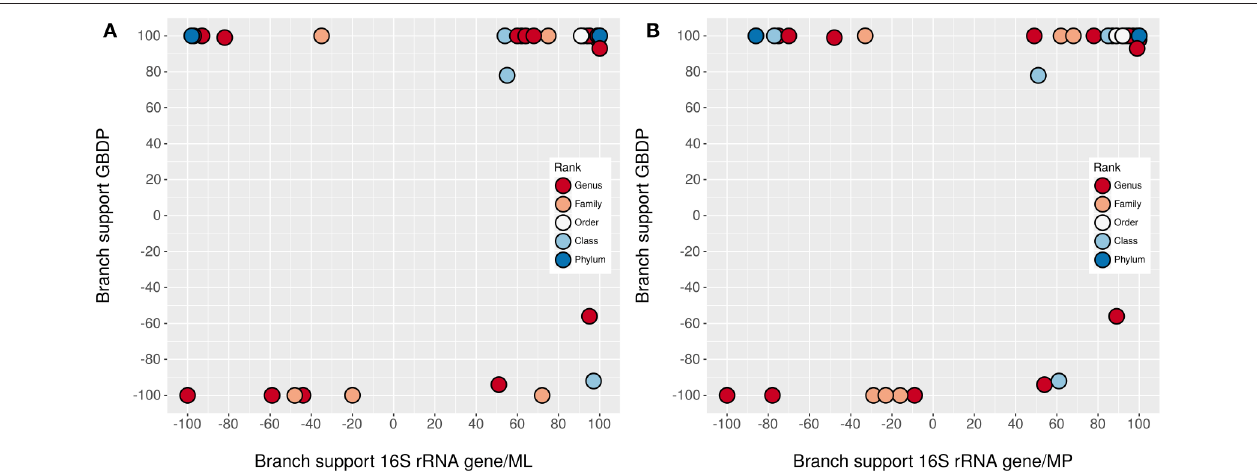
FIGURE 5 | Comparison of branch support. Shown are the negative or positive branch support values for each taxon inferred from whole genomes with GBDP in comparison to those inferred from 16S rRNA gene sequences with ML (A) and MP (B) . The colors indicate the taxonomic rank. The upper right corner contains the taxa significantly supported by all methods, the lower left corner those significantly opposed by all methods. The other two corners, which would indicate a significant conflict between the methods, are empty. Jitter was used to avoid